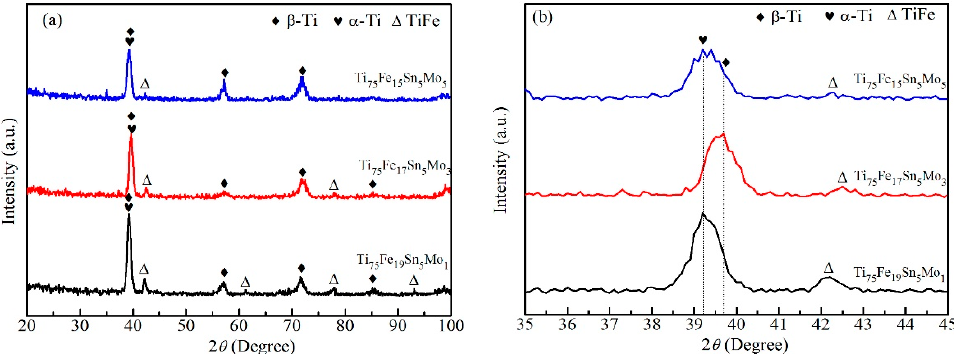
Figure 1. X-ray di ff ractometer (XRD) patterns of the Ti–Fe–Sn–Mo alloys. ( a ) 20 ◦ –100 ◦ ; ( b ) 35 ◦ –45 ◦ Figure 1. X-ray diffractometer (XRD) patterns of the Ti–Fe–Sn–Mo alloys. ( a ) 20°–100°; ( b ) 35°–45°.